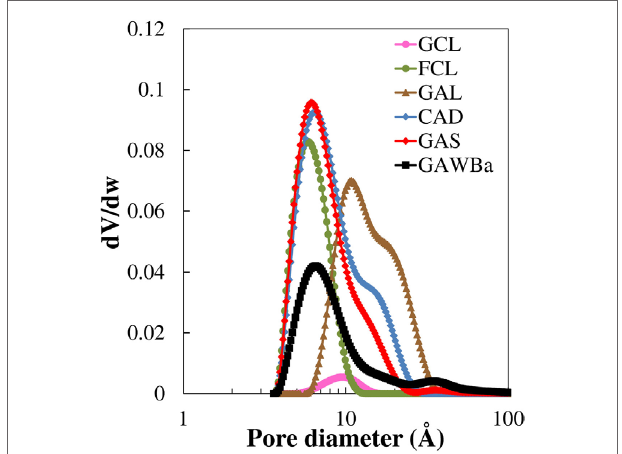
FigUre 3 | Pore size distributions calculated from the n 2 adsorption isotherms .